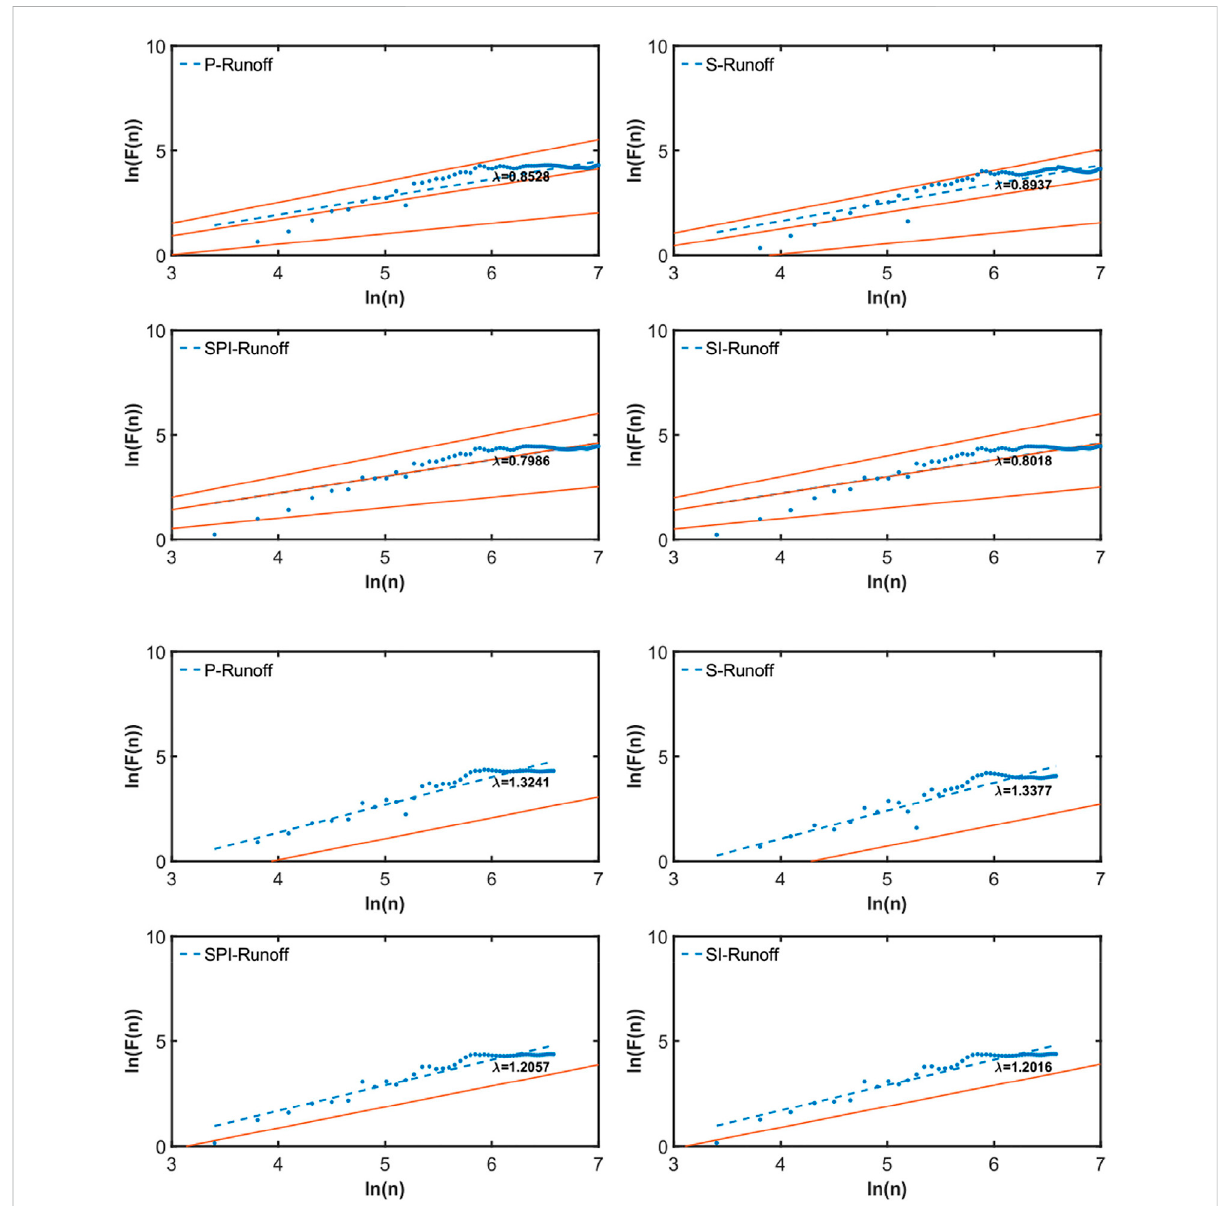
FIGURE 14 Power-law cross-correlations between ANN-reconstructed (upper four subplots) and ANN-forecasted (lower four subplots) runoff and in-situ Kratie runoff. The slopes of dashed blue lines represent the fi tted λ DCCA , and the three red solid lines from top to bottom denote λ DCCA (cid:1) 1, λ DCCA (cid:1) 0 . 8, and λ DCCA (cid:1) 0 . 5,